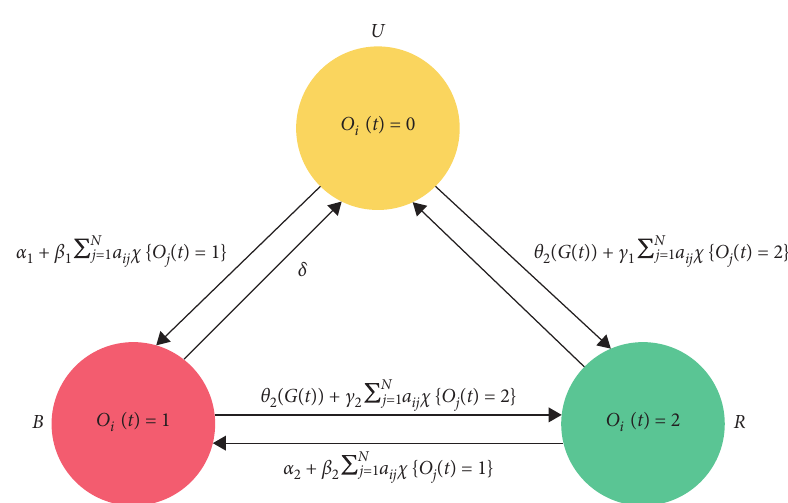
Figure 1: The diagram of state transition of the user u